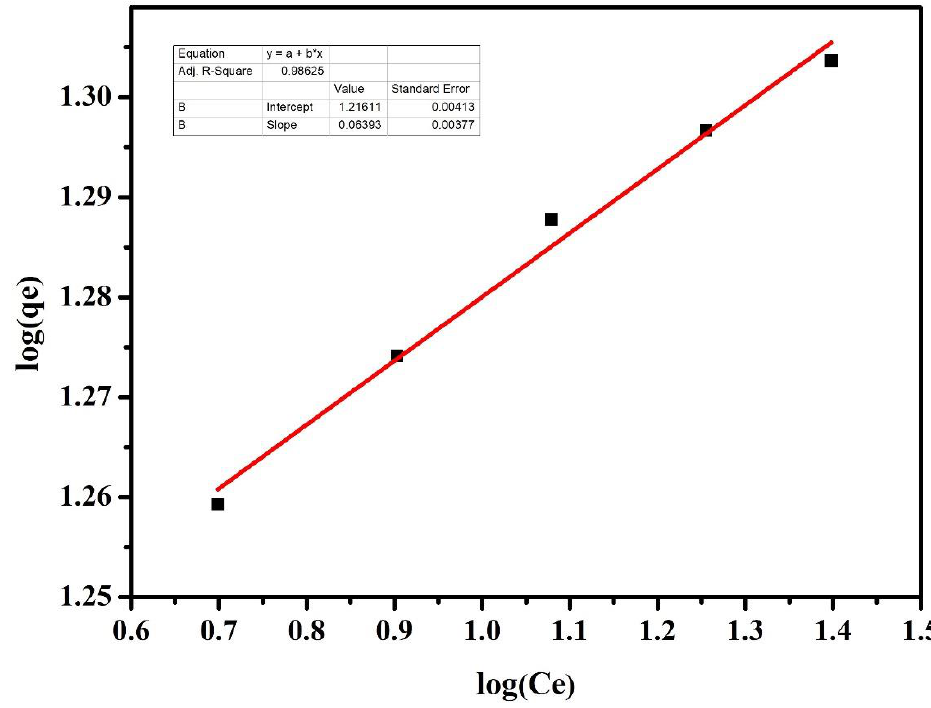
Figure 7. Ba 0.54 Na 0.46 Nb 1.29 W 0.37 O 5 in the Freundlich curve for blue methylene adsorption.